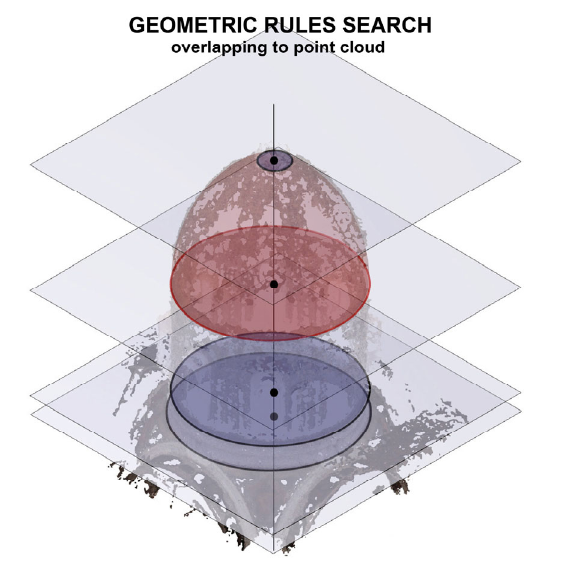
Figure 10. Napoli, S. Maria di Costantinopoli Church: rules